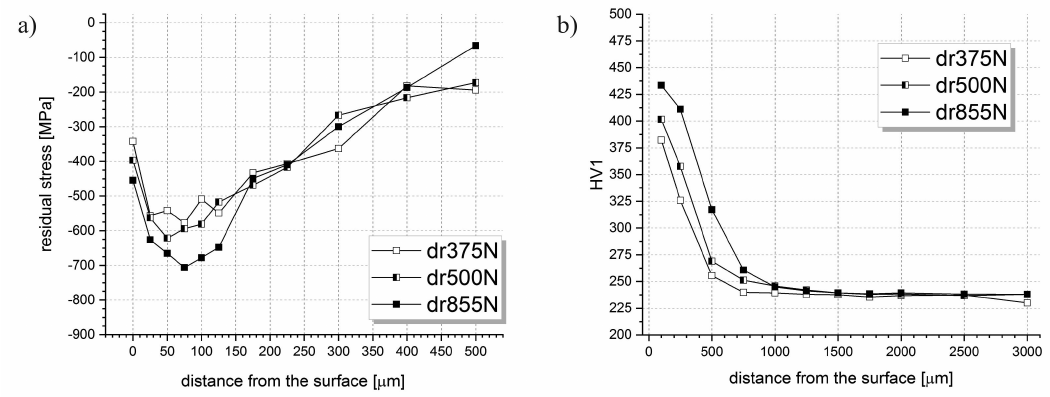
Figure 4. Residual stress depth profiles in longitudinal direction ( a ) and near-surface hardness distribution ( b ) after deep rolling at room temperature applying deep rolling forces between 375N and